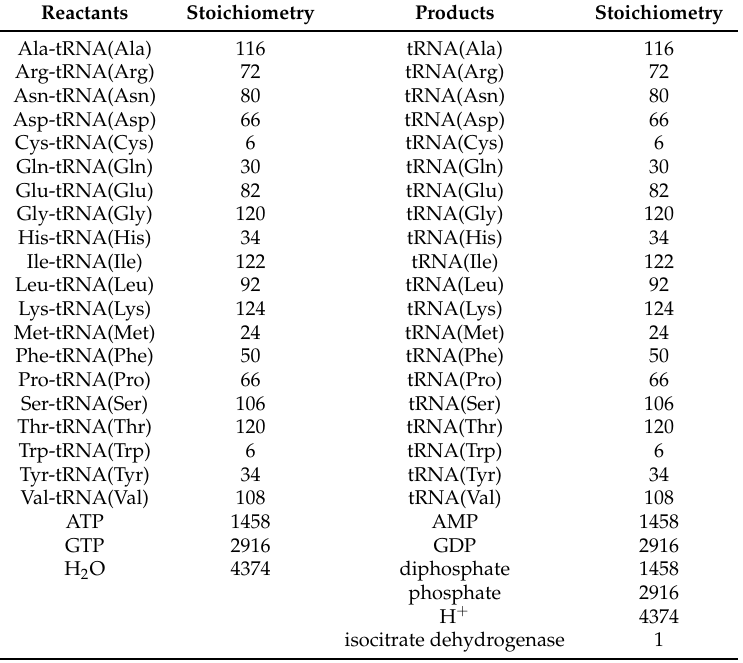
Table A2. Synthesis reaction for producing the enzyme isocitrate dehydrogenase in the Yeast 6.06 model. The two gene products that form this enzyme participate in the complex as dimers. Therefore, the counts in Table A1 are multiplied by two and added up for the synthesis